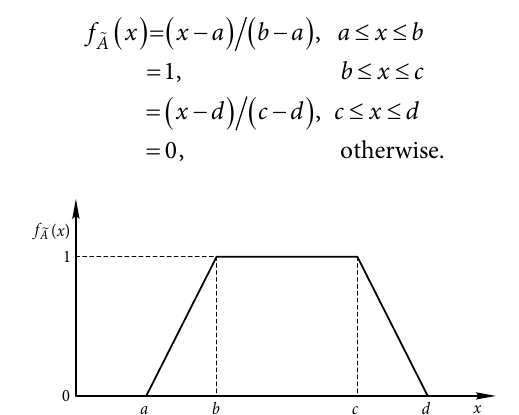
Fig. 3. Membership function of trapezoidal fuzzy